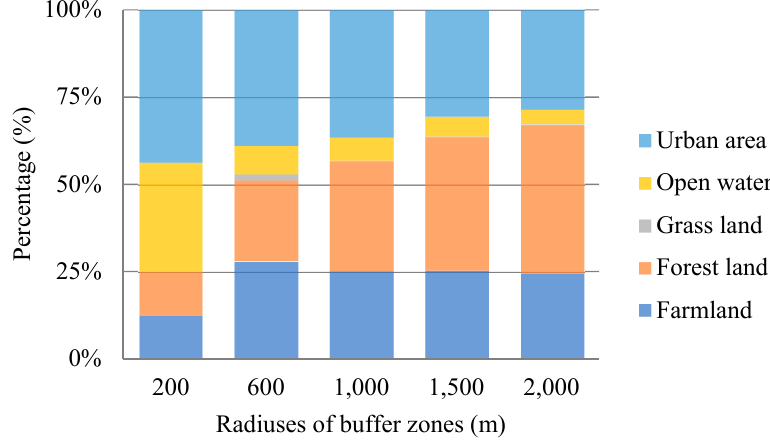
Figure 4. Proportion of the area of landscape composition types in the total buffer zone area with each radius.